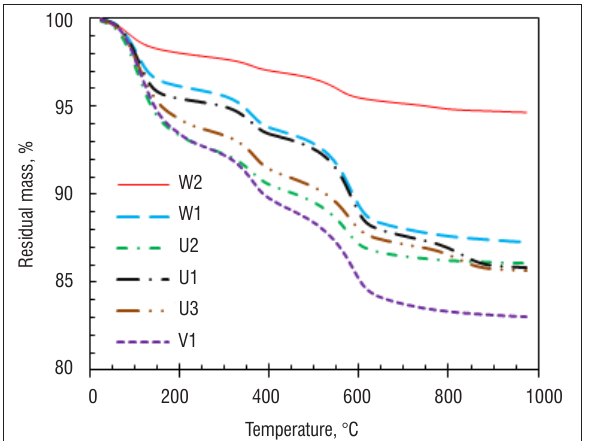
Figure 3: Attenuated total reflection Fourier transform infrared (ATR– FTIR) spectra of clay samples.